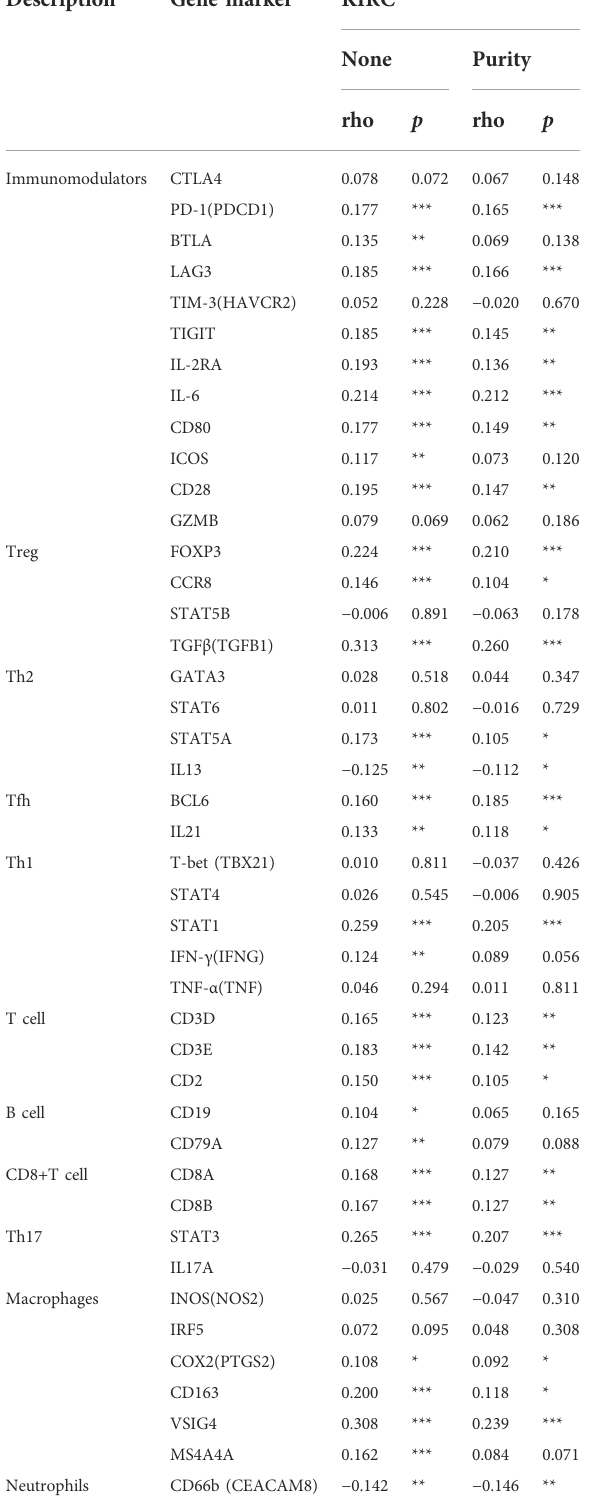
TABLE 3 Correlation analysis between CALR and related genes and markers of immune cells in TIMER2.0. Description Gene marker